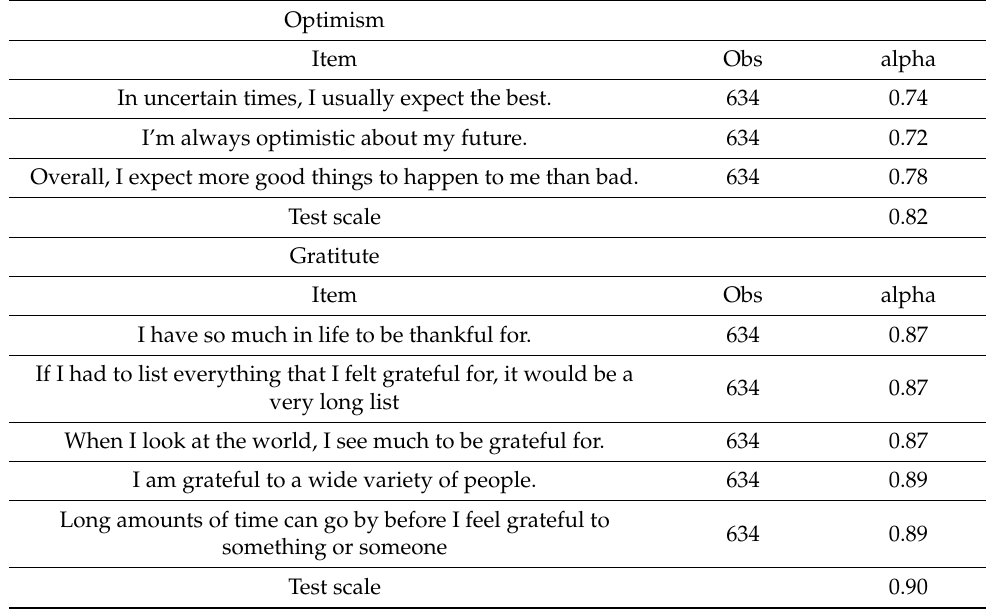
Table 1. Cronbach’s Alpha correlation for gratitude and optimism. Optimism Item Obs alpha In uncertain times, I usually expect the best. 634 0.74 I’m always optimistic about my future. 634